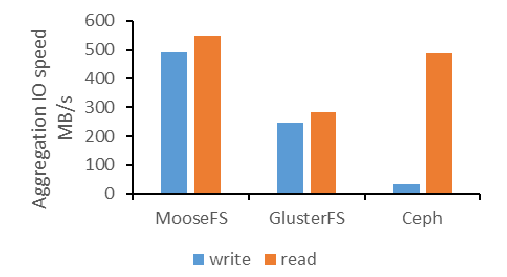
Figure 3. The aggregation IO speed comparison of three distributed file systems